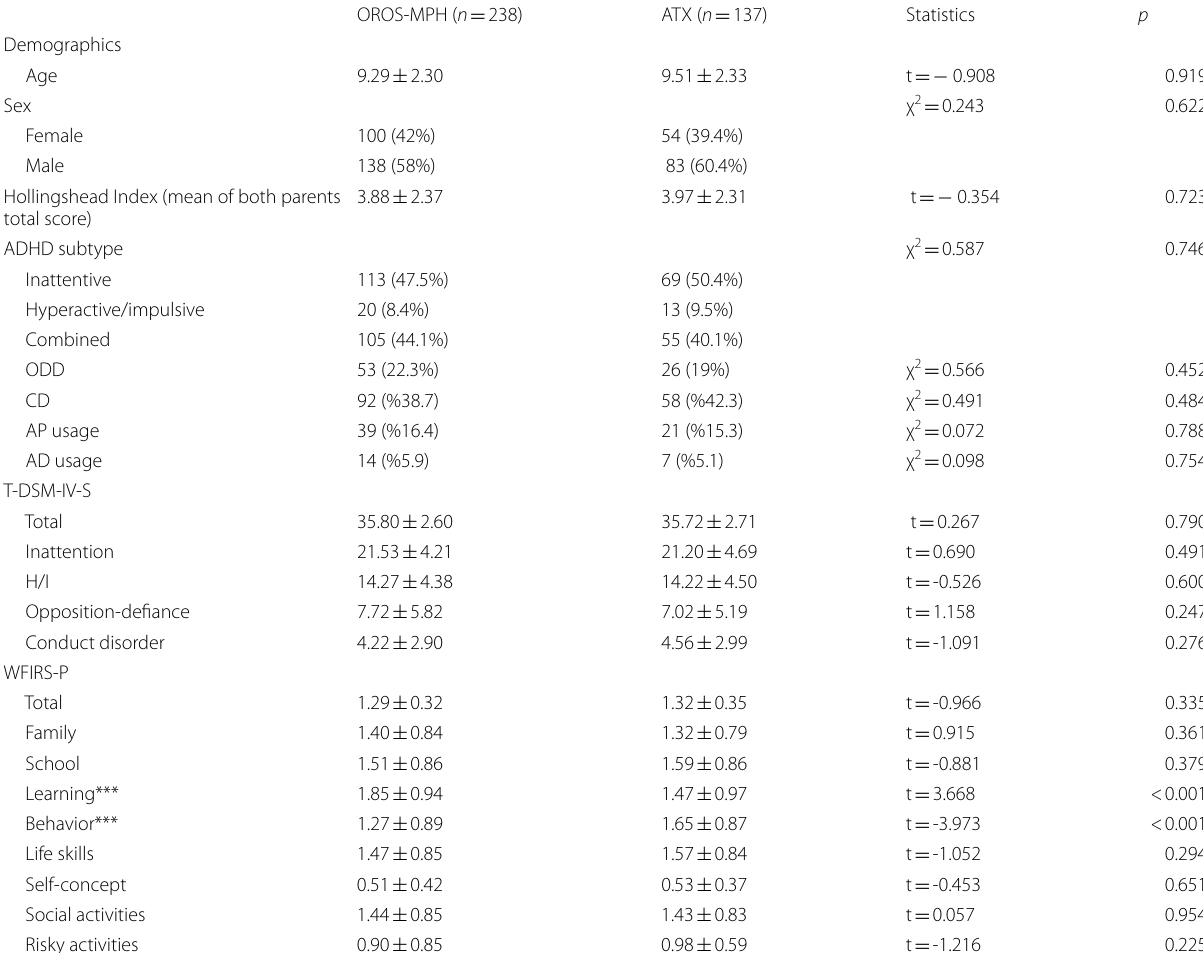
Table 1 Descriptive statistics for two groups in the baseline